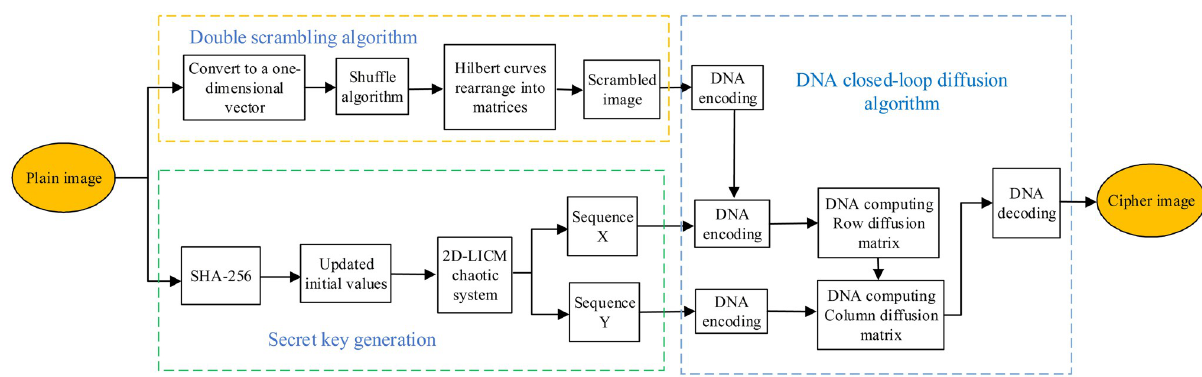
Fig 6. The encryption flow diagram of the proposed scheme.